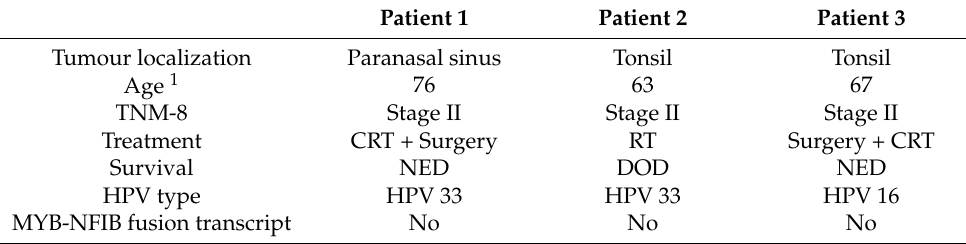
Table 2. Patients initially diagnosed with adenoid cystic carcinoma (AdCC) and their